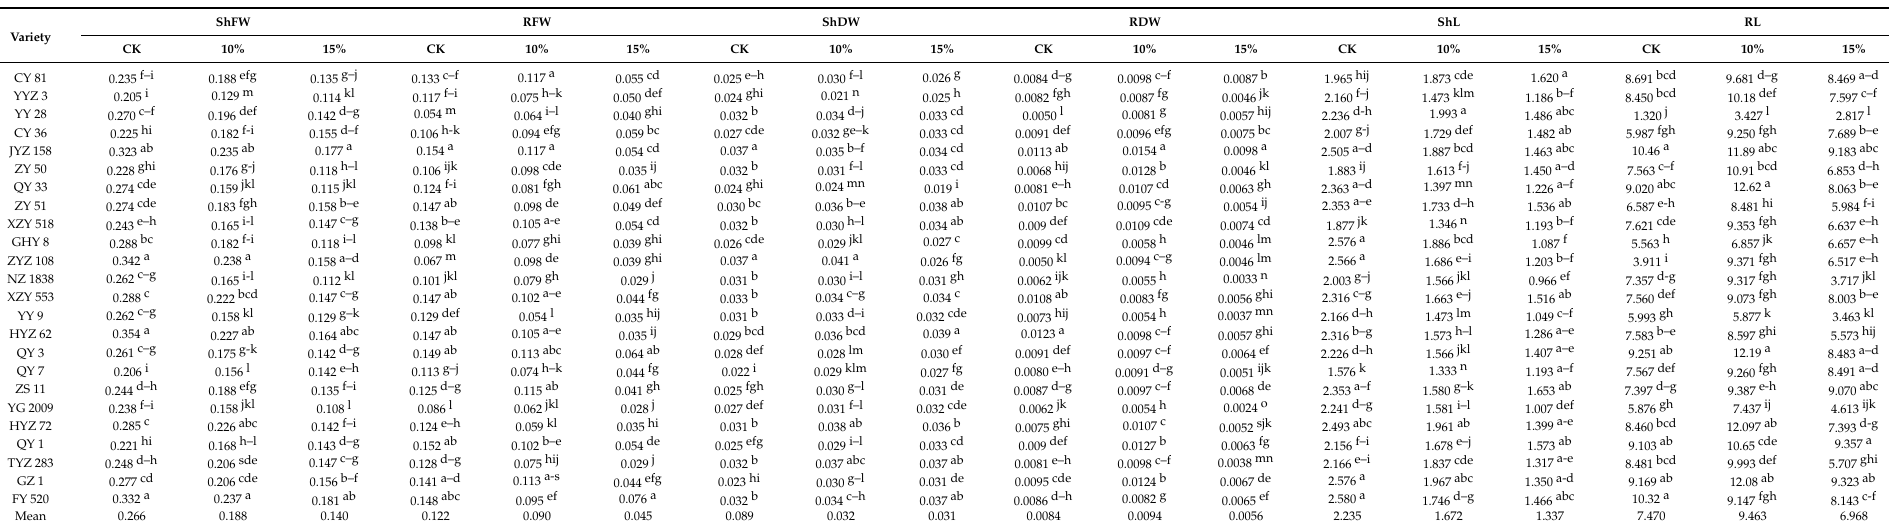
Table 2. Seedling growth-related traits under PEG-6000 induced drought